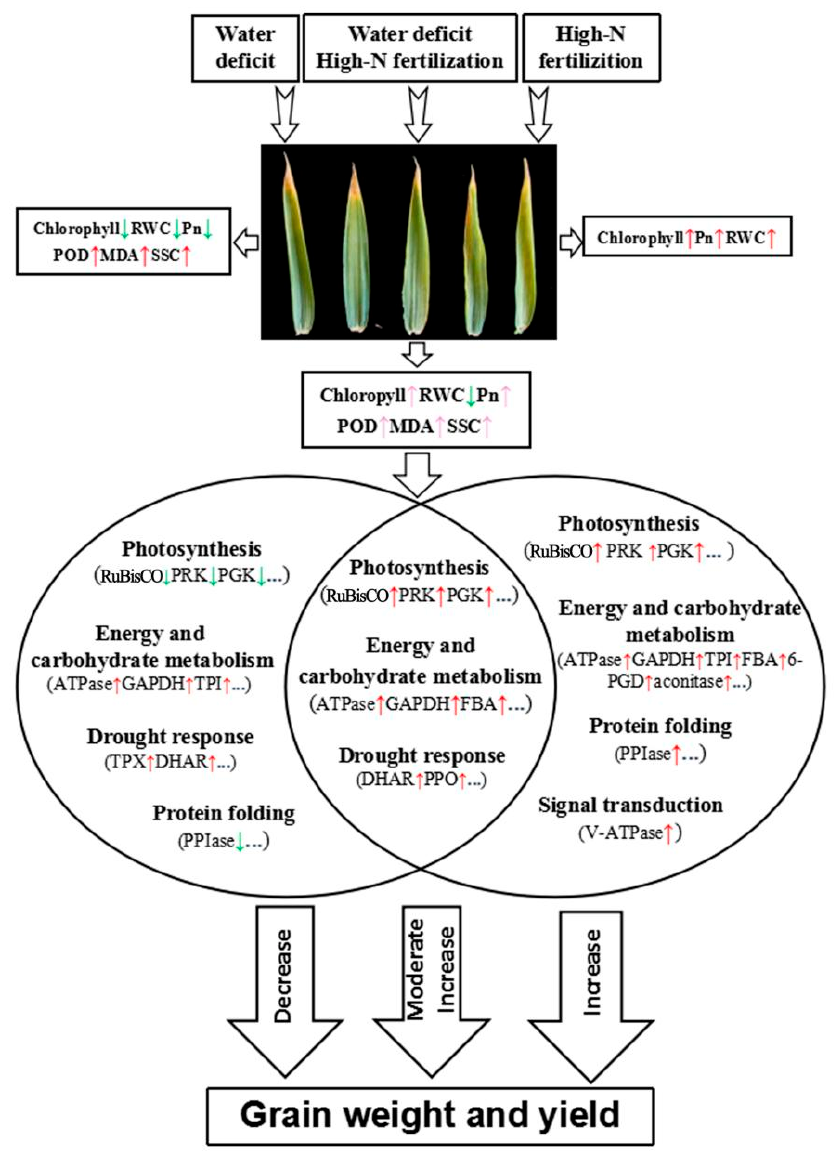
Figure 8. A putative synergistic response network in flag leaf proteomes to water-deficit and high-N conditions. RWC, relative water content; Pn, net photosynthetic rate; SSC, soluble sugar content; RuBisCO, ribulose-1,5-bisphosphate. carboxylase / oxygenase; PRK, phosphoribulokinase; PGK, phosphoglycerate kinase; TPX, thioredoxin-dependent peroxidase; DHAR, dehydroascorbate reductase; GAPDH, glyceraldehyde 3-phosphate dehydrogenase; TPI, triosephosphate isomerase; FBA, fructose-1,6-bisphosphate aldolase; 6-PGD, 6-phosphogluconate dehydrogenase; PPIase, peptidyl-prolyl cis–trans isomerase. The red arrow represents upregulation, pink and green arrows represent moderate upregulation and downregulation,